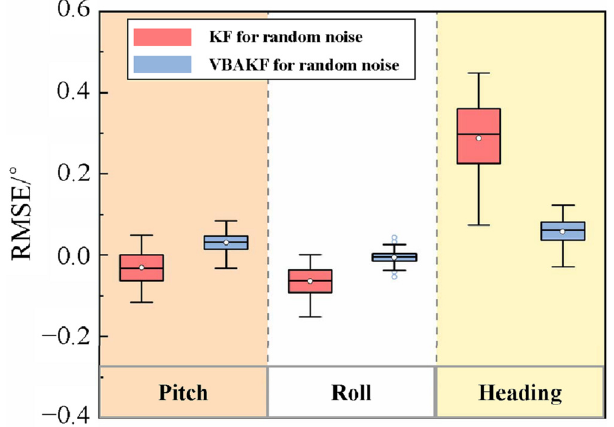
Figure 4. Filtering error box plot when the measured noise covariance is an unknown time-varying